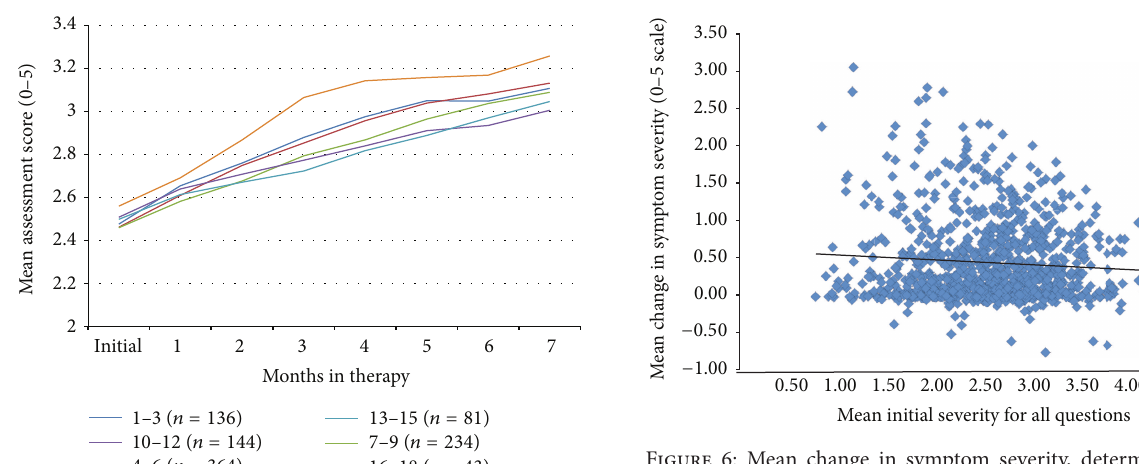
Figure 6: Mean change in symptom severity, determined by all answered questions on a 0–5 scale as a function of initial symptom severity ( R 2 = 0.005).